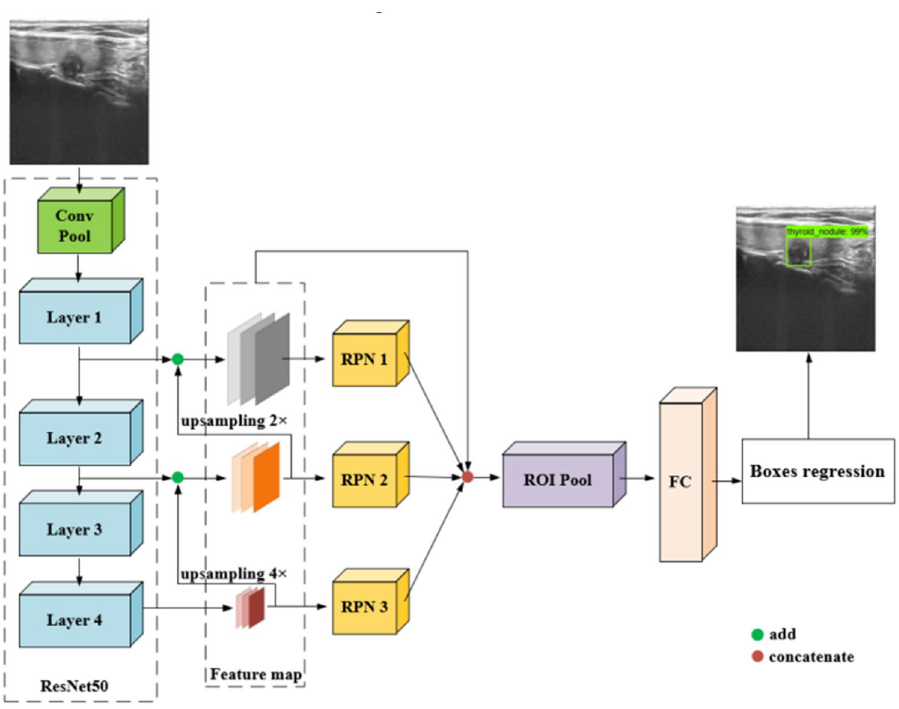
Figure 5. Localization network structure